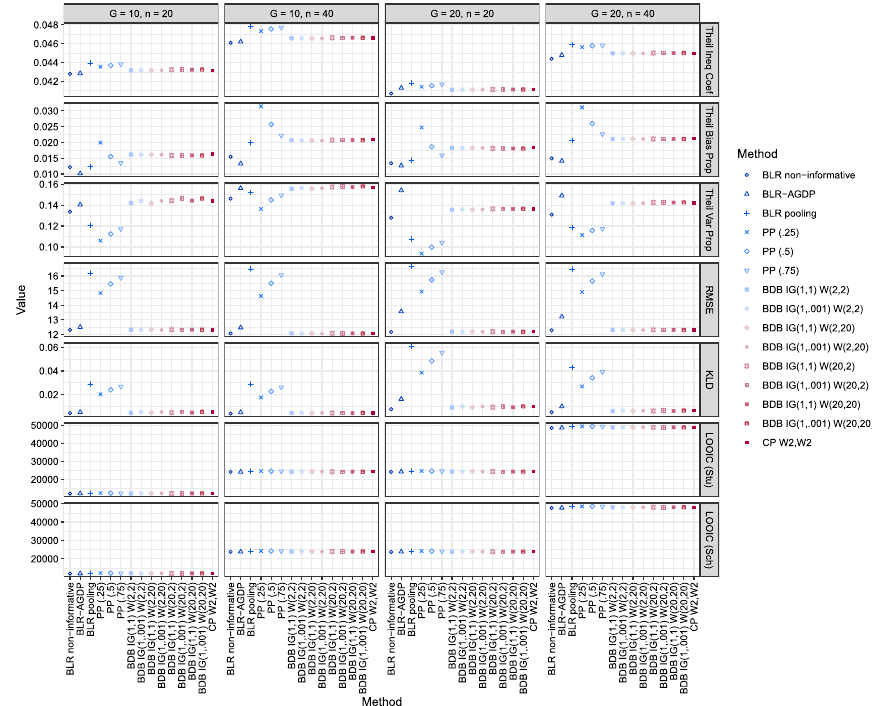
Fig. 5 Prediction performance of different borrowing methods under the heterogeneous